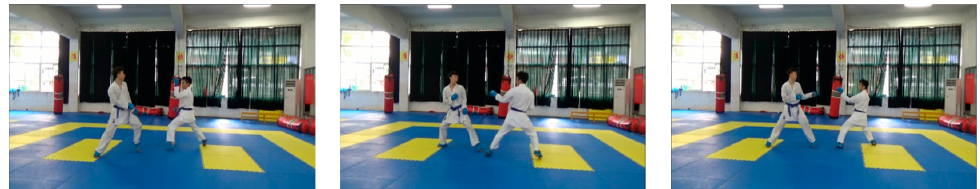
Figure 8. Three random perspectives from the test video.